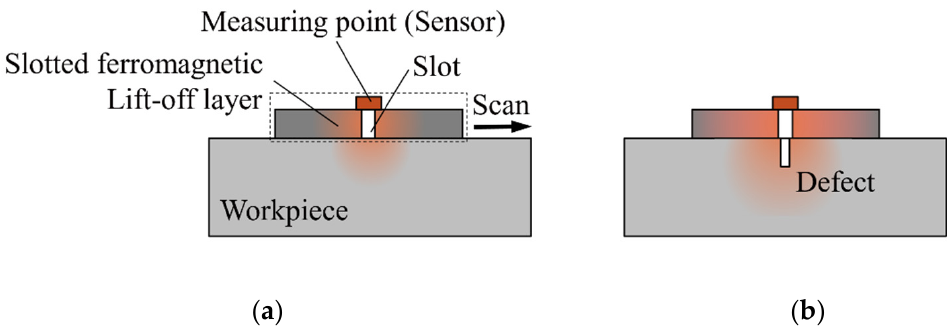
Figure 2. The method of the slotted ferromagnetic lift-off layer ( a ) without defects and ( b ) with a defect in the workpiece.